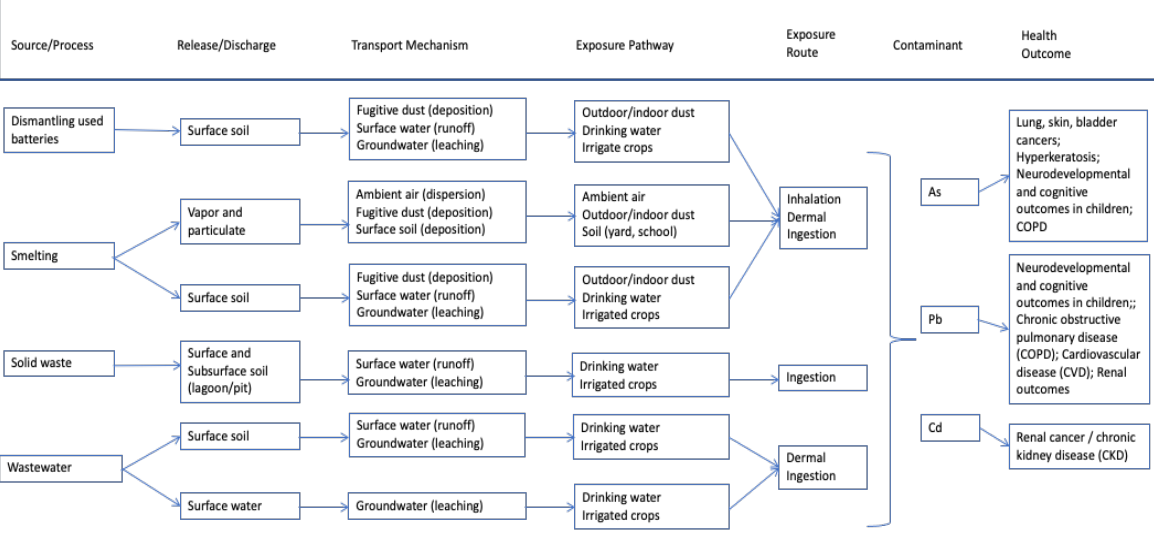
Figure 3. Generalized conceptual site model for used lead acid battery recycling activities.